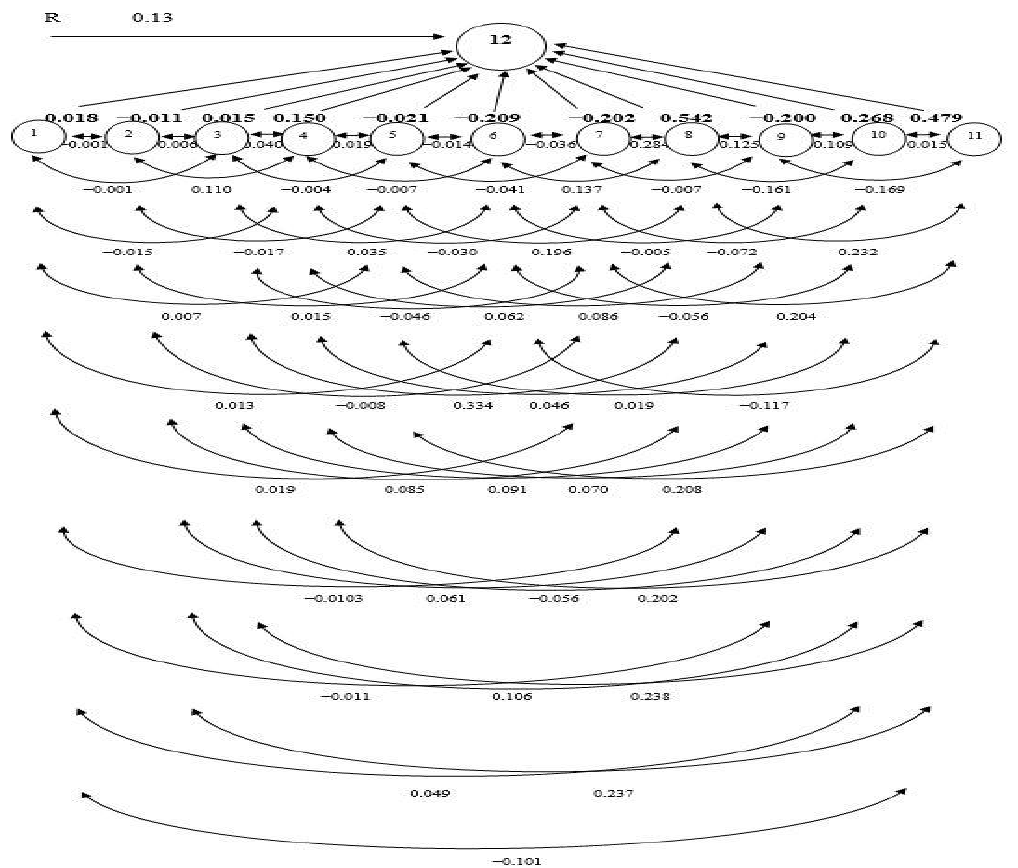
Figure 1. The path coefficient (PC) diagram representing cause and effect relationships among quantitative traits and grain yield. (1. days to 50% flowering; 2. plant height; 3. number of effective tillers per hill; 4. flag leaf length; 5. panicle length; 6. number of primary branches per panicle; 7. number of secondary branches per panicle; 8. number of filled spikelets per panicle, 9. spikelet sterility, 10. 1000-grain weight; 11. harvest index; 12. Grain yield (t/ha); R — residual effect).